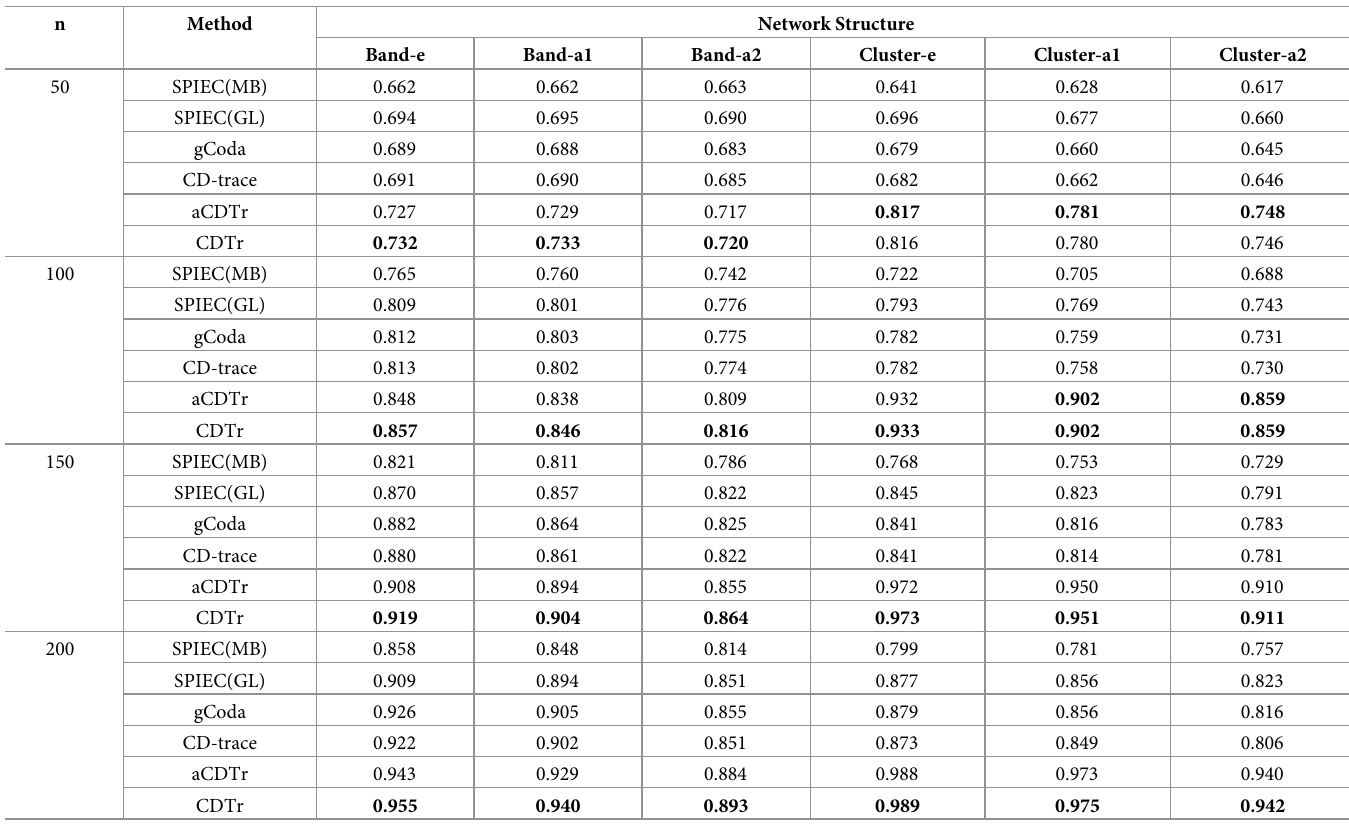
Table 2. The mean AUC scores of different methods under different